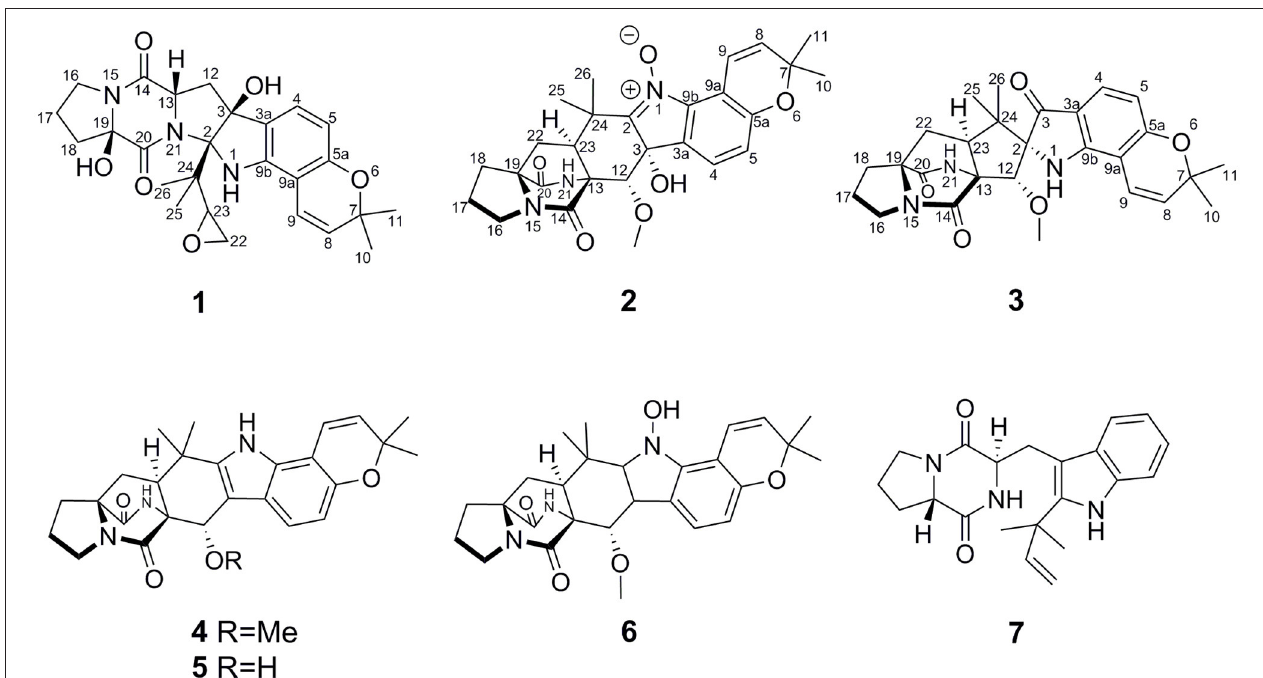
FIGURE 2 | The structures of the isolated